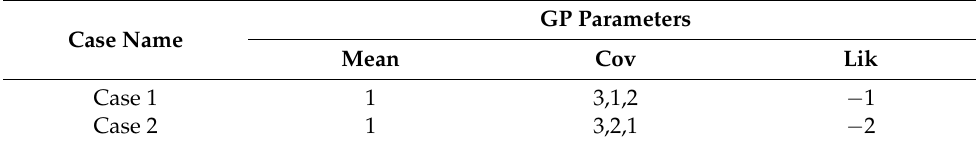
Table 6. Parameters used in cases.